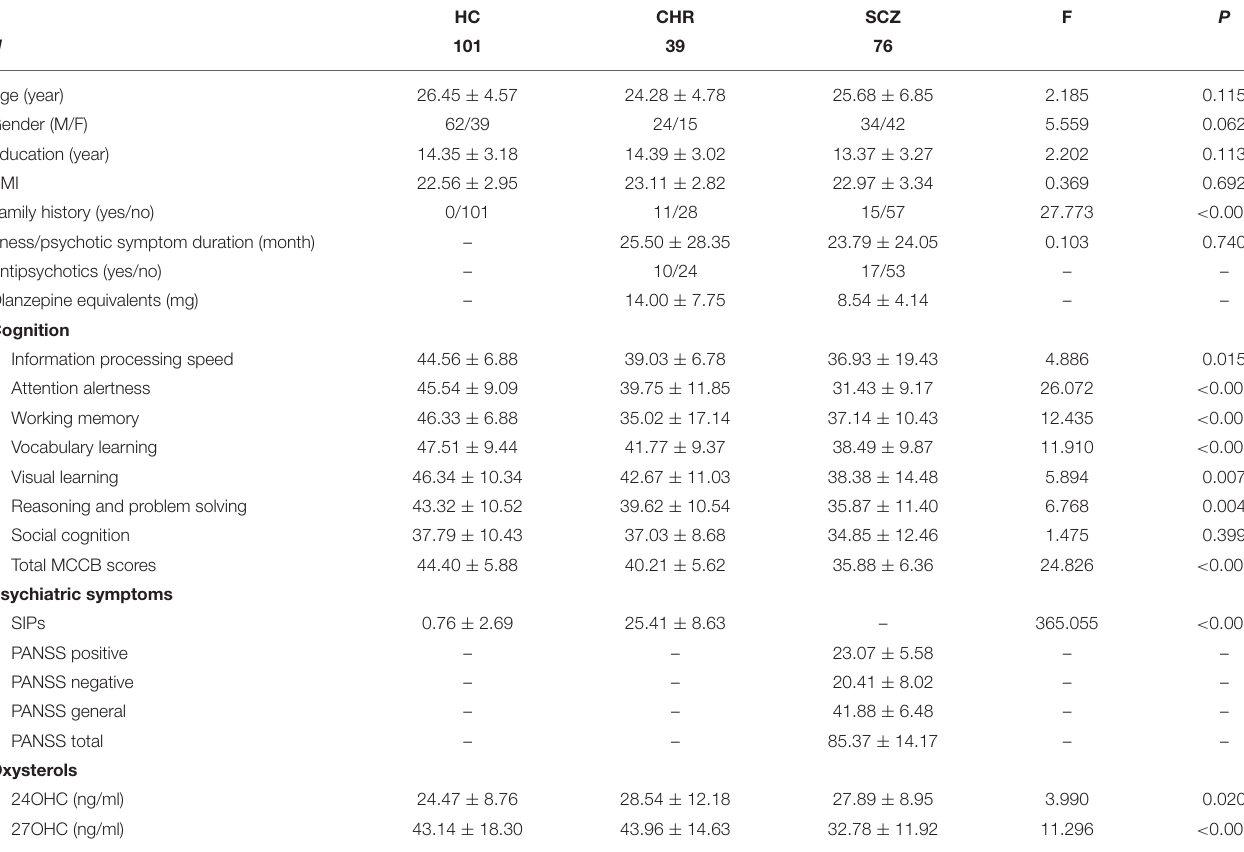
TABLE 1 | Demographic variables and clinical characteristics in schizophrenia patients, CHR individuals, and